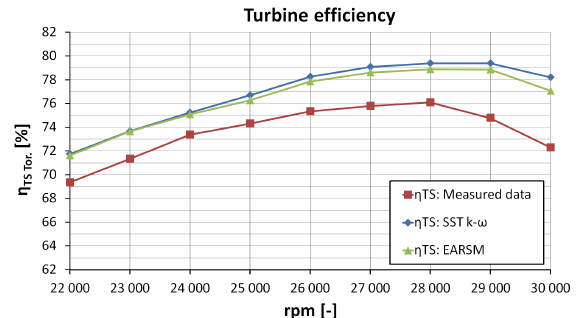
Figure 14. Comparison of achieved